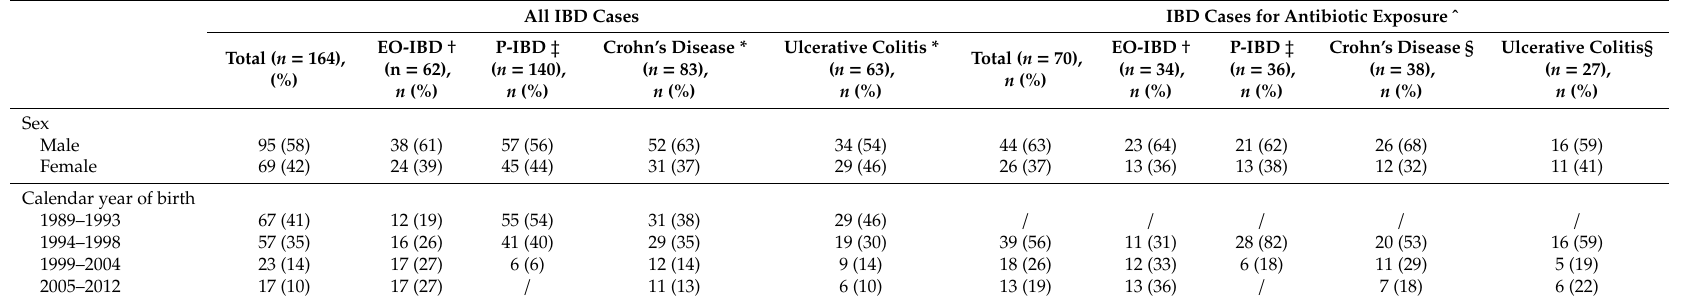
Table 1. Distribution of sex, year of birth and age at diagnosis IBD